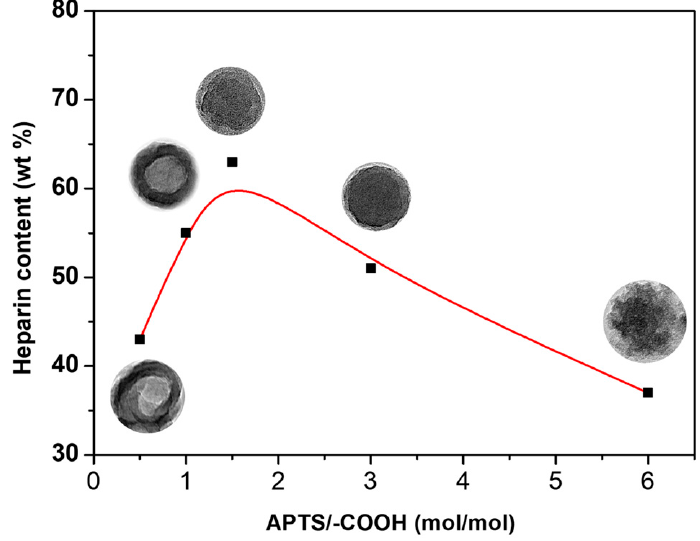
Figure 3. Heparin content vs APTS/-COOH molar ratio with corresponding morphological structure evolution.